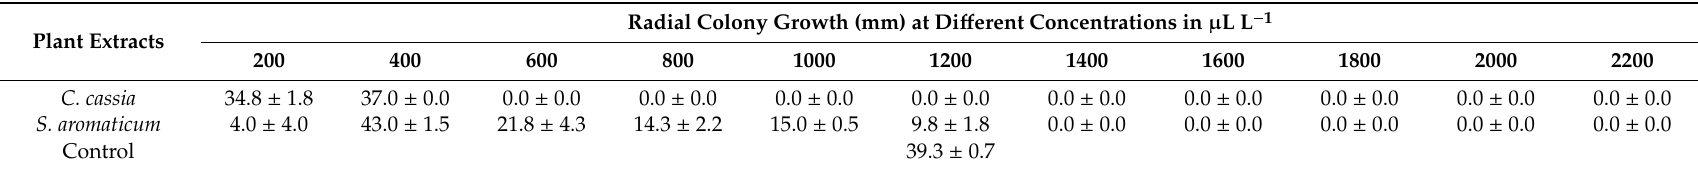
Table 2. Radial colony growth of Botrytis cinerea 48 h after reinoculation (after treatment with extracts). Results are presented as mean ± SD ( n = 4) ( p < 0.05). Plant